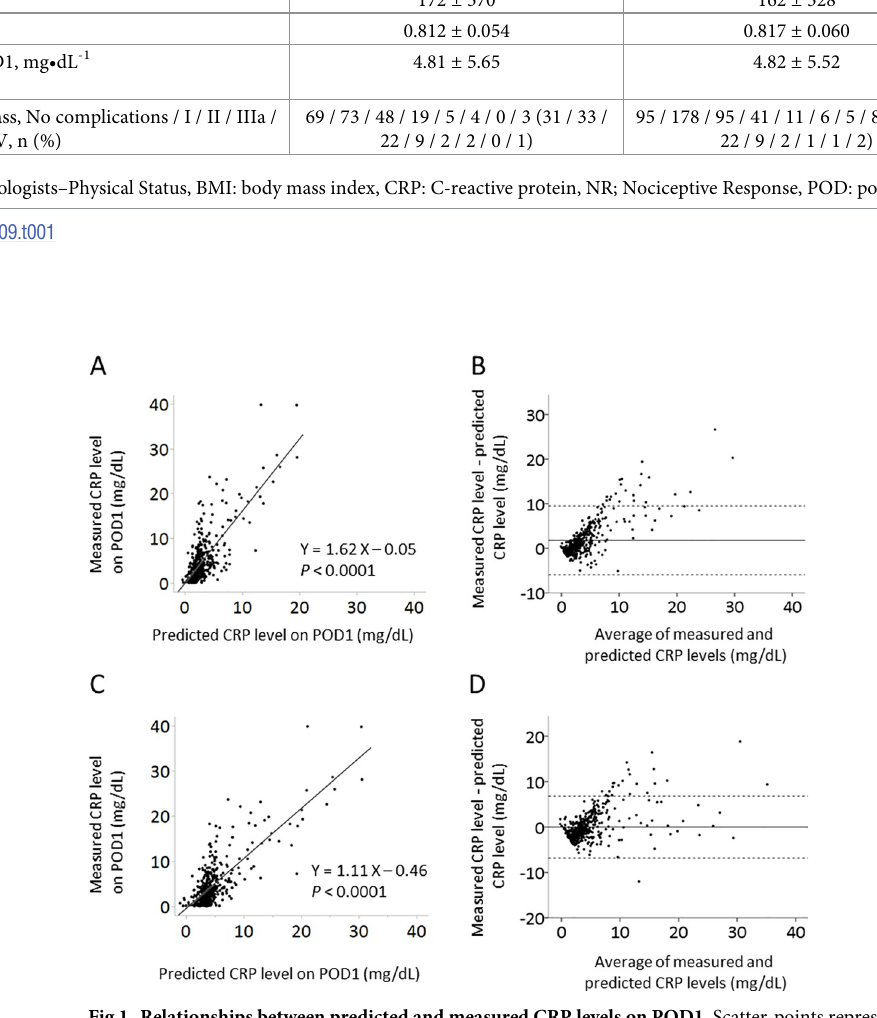
Fig 1. Relationships between predicted and measured CRP levels on POD1. Scatter-points represent actual data of measured and predicted CRP values using the previous model (A) and modified model (C). In the Bland-Altman plot of measured and predicted CRP levels on POD1 using the previous model (B) and modified model (D), continuous line shows mean difference in measured and predicted CRP levels on POD1, while dotted line shows upper and lower limits of agreement. CRP: C-reactive protein, POD: postoperative